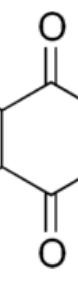
Figure 4. Juglone.